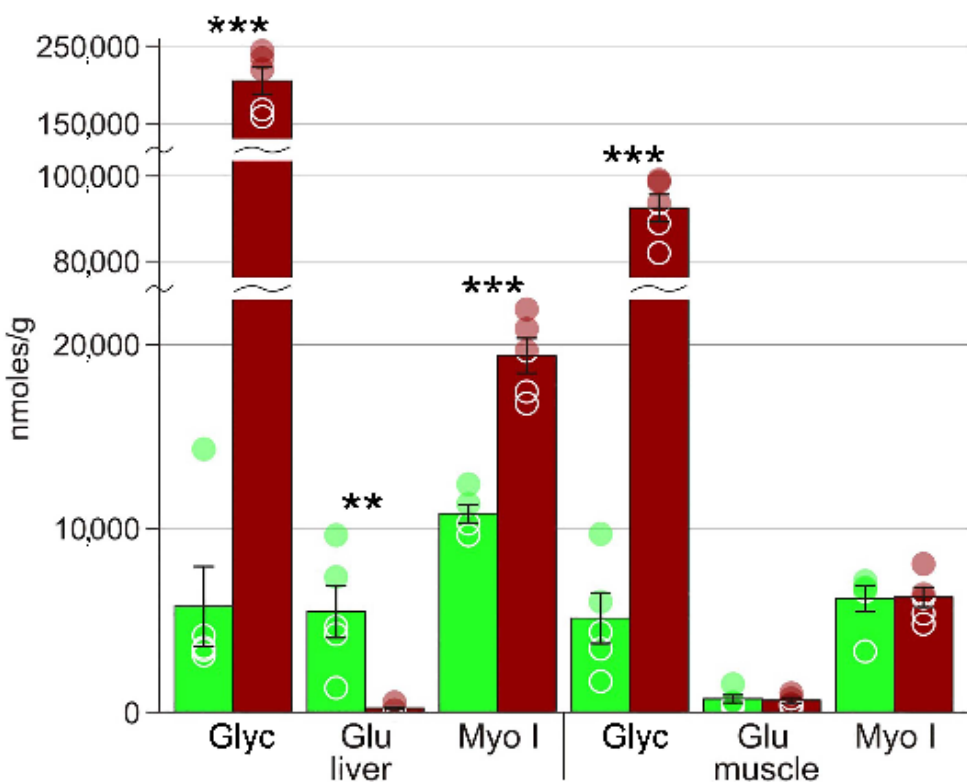
Figure 3. The concentrations of substances with cryoprotectant properties. Green columns, control; red, frozen; ** Welch test p < 0.01; *** p < 0.001; circles, individual data points; bar, SE. Glyc, glycerol; Glu, glucose; Myo I; myo-inositol.